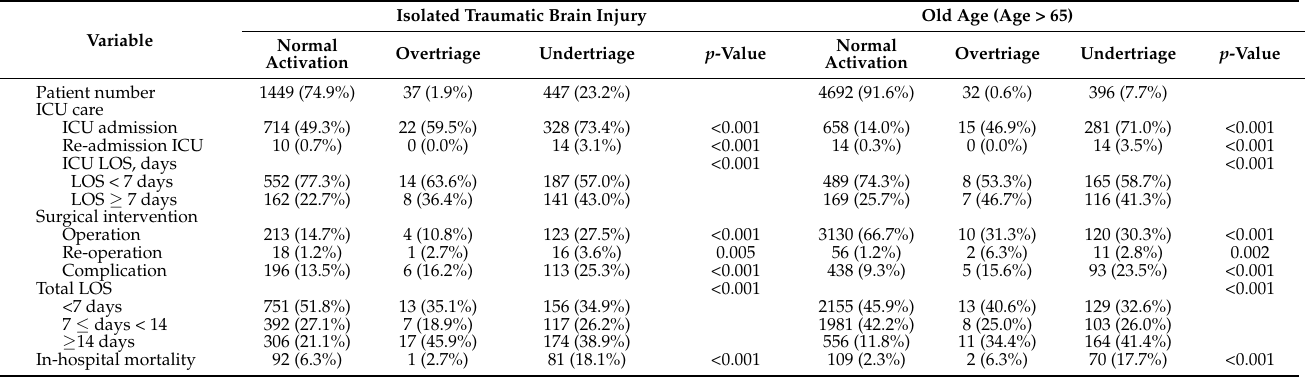
Table 5. Comparison of demographic characteristics of undertriage and overtriage patients in isolated TBI population and old age